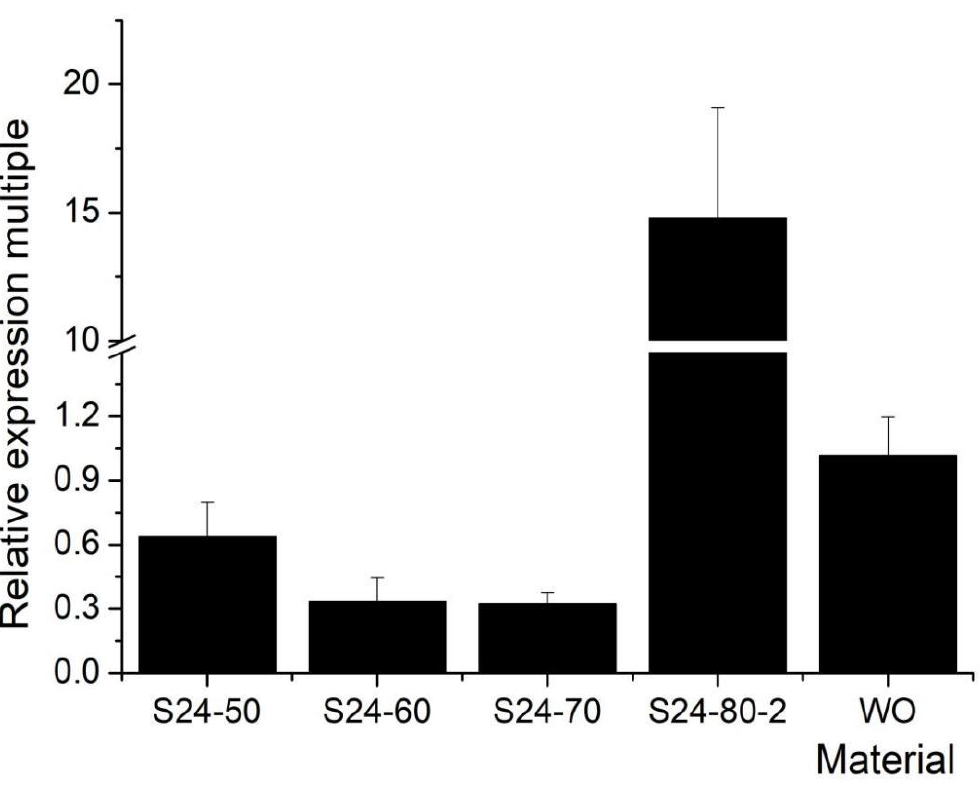
Figure 4. Expression pattern of LOC_0s10g37880 . The Y -axis indicates the relative expression multiple, and the X -axis indicates the materials. W0 is short for HJX74 as the corresponding control. S24-50, S24-60, S24-70 and S24-80-2 represent the expression of genes LOC_Os10g37850.2 , LOC_Os10g37860 , LOC_Os10g37870 , and LOC_Os10g37880 in S24, respectively.